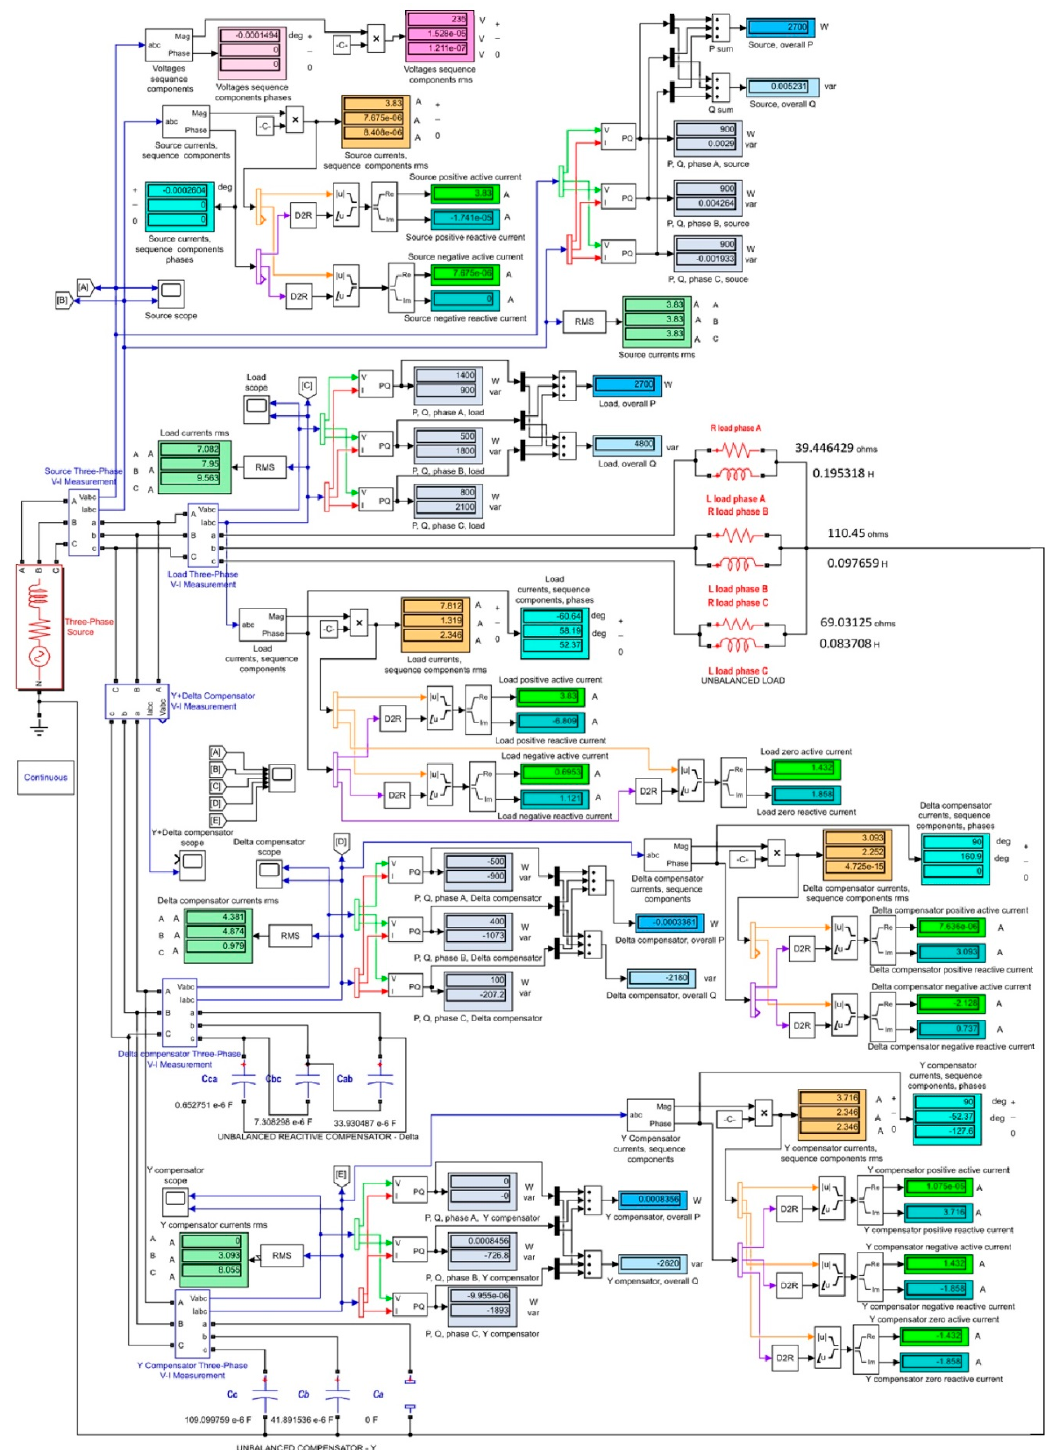
Figure 5. The Matlab model used to study the BCC operation considered in the case study.